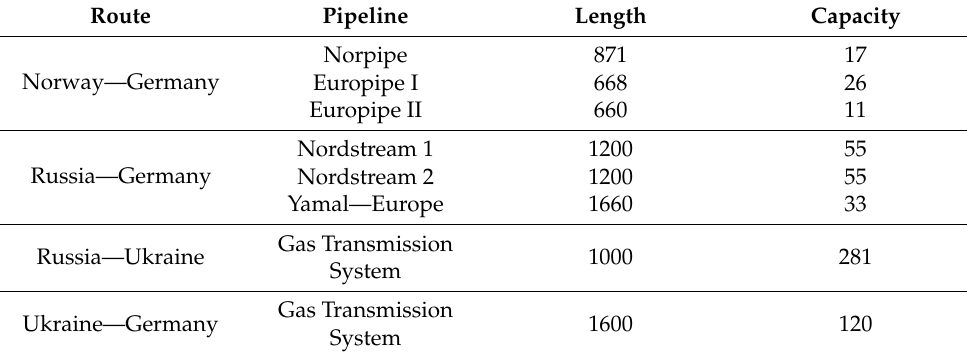
Table 1. Specifications of the selected gas